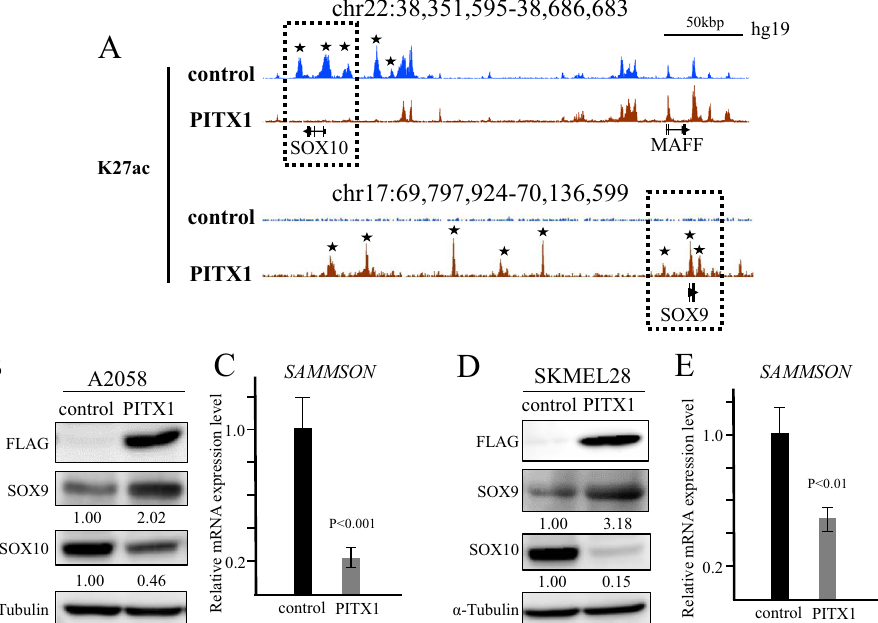
Figure 2. H3K27ac ChIP-seq in PITX1 -expressing cells. ( A ) Integrated Genome Browser (IGB) screenshots of ChIP-seq data shows H3K27ac at the SOX9 and SOX10 loci in PITX1 overexpressing A2058 (red) and control cells (blue). Stars indicates the regions where the peak of H27Kac differs between PITX1 -overexpressing cells and control cells. ( B ) Western blotting analysis of the protein level of PITX1 (Flag tagged), SOX9 and SOX10 in A2058 cells at 48 h after infection with PITX1 expressing or control lentivirus vector. The expression levels of SOX9 and SOX10 were normalized to α-tubulin levels. Cropped blots were used in this figure. Original full-length blots are presented in Supplementary Fig. S8. ( C ) qRT-PCR analysis of relative SAMMSON RNA expression levels in PITX1 and control lentivirus vector infected A2058 cells. Expression in the vector control cells was arbitrarily set at 1. GAPDH mRNA expression was used as the internal control. Data are presented as means ± S.D. of three independent experiments (P < 0.001). ( D ) Western blotting analysis of the protein level of PITX1 (Flag tagged), SOX9 and SOX10 in SKMEL28 cells at 48 h after infection with PITX1 expressing or control lentivirus vector. The expression levels of SOX9 and SOX10 were normalized to α-tubulin levels. Cropped blots were used in this figure. Original full-length blots are presented in Supplementary Fig. S8. ( E ) qRT-PCR analysis of relative SAMMSON RNA expression levels in PITX1 and control lentivirus vector infected SKMEL28 cells. Expression in the vector control cells was arbitrarily set at 1. GAPDH mRNA expression was used as the internal control. Data are presented as means ± S.D. of three independent experiments (P < 0.01). All the bar graphs were created using